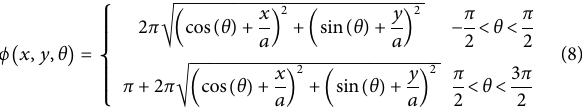
( Figure 2 ), where a cylindrical silicon waveguide is placed at a distance ( g ) from a metallic substrate.